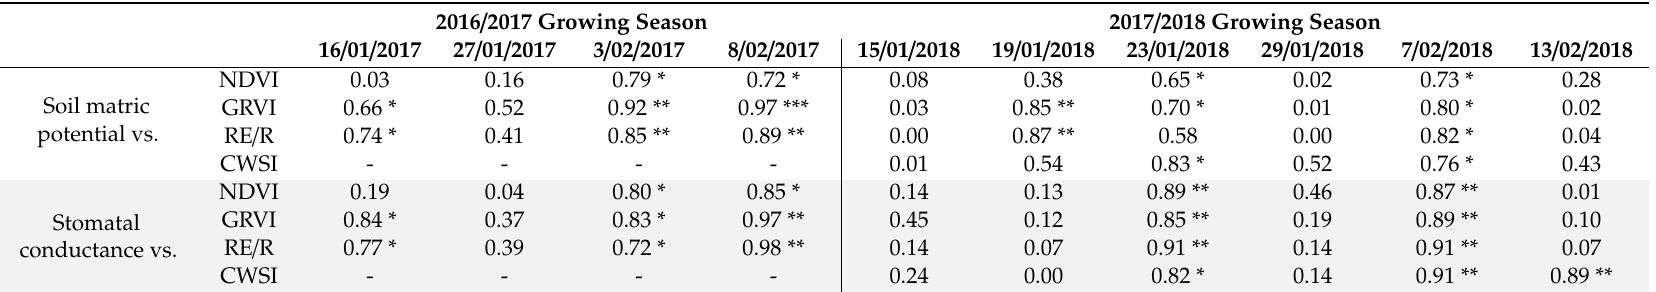
Table 4. Coe ffi cient of determination (r 2 ) obtained for the relationship between the stomatal conductance and soil matric potential with the thermal (CWSI) and spectral indices (NDVI, GRVI and RE / R) for each measurement date.